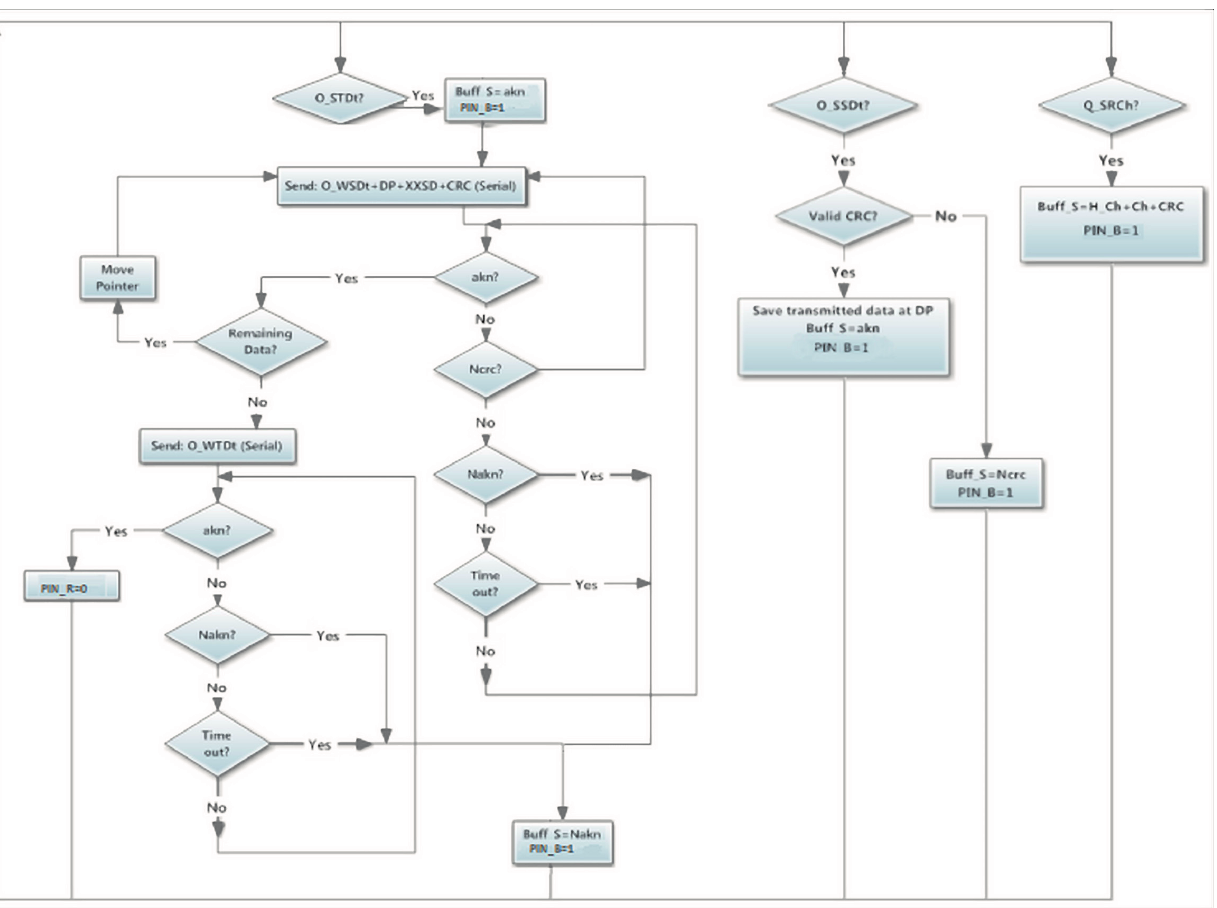
Figure 9. Flowchart of wireless orders from Slave